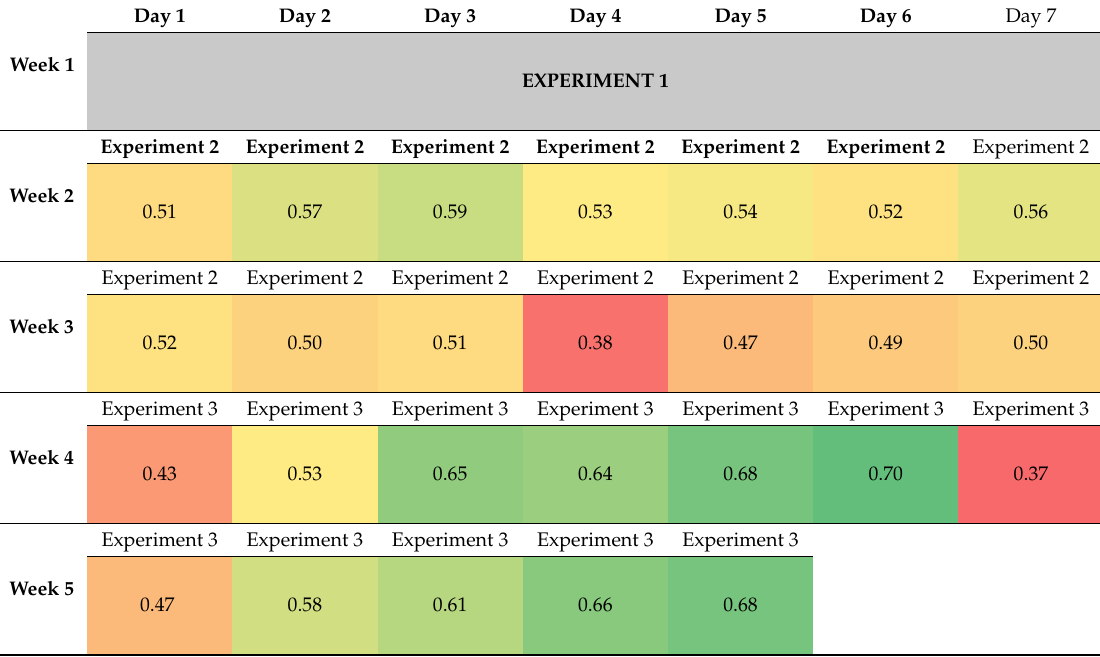
Table 2. Mean daily e ffi ciency.